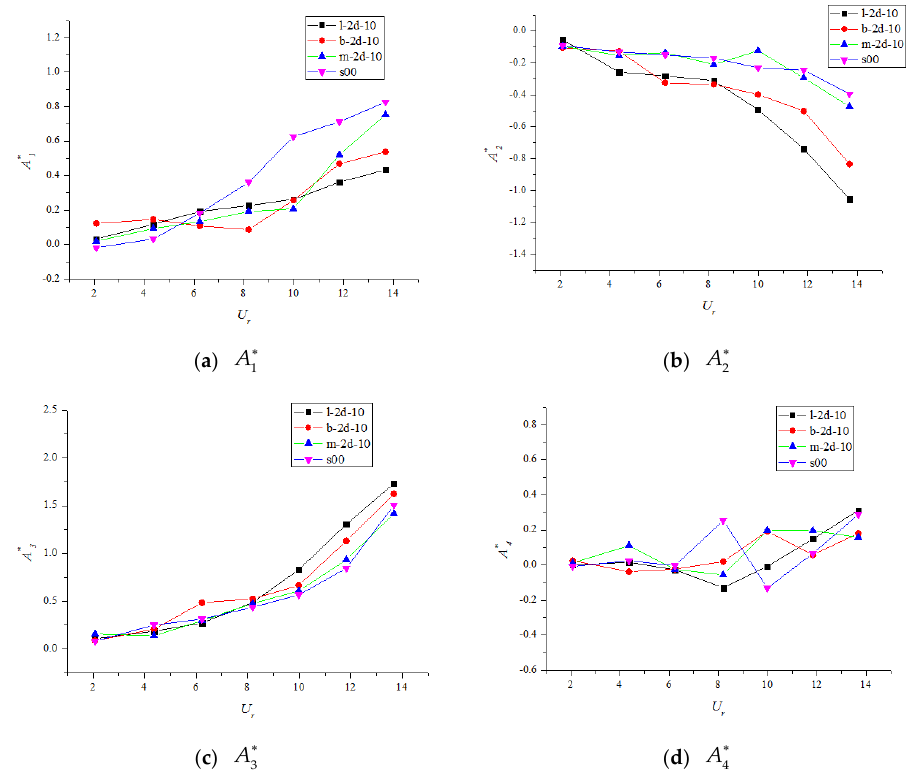
∗ ( i = 1 − 4) for test cases with di ff erent suction flow rates. H (   1 4 i ) for test cases with different suction flow rates. Figure 7. ( a – d ) Flutter derivatives H i i